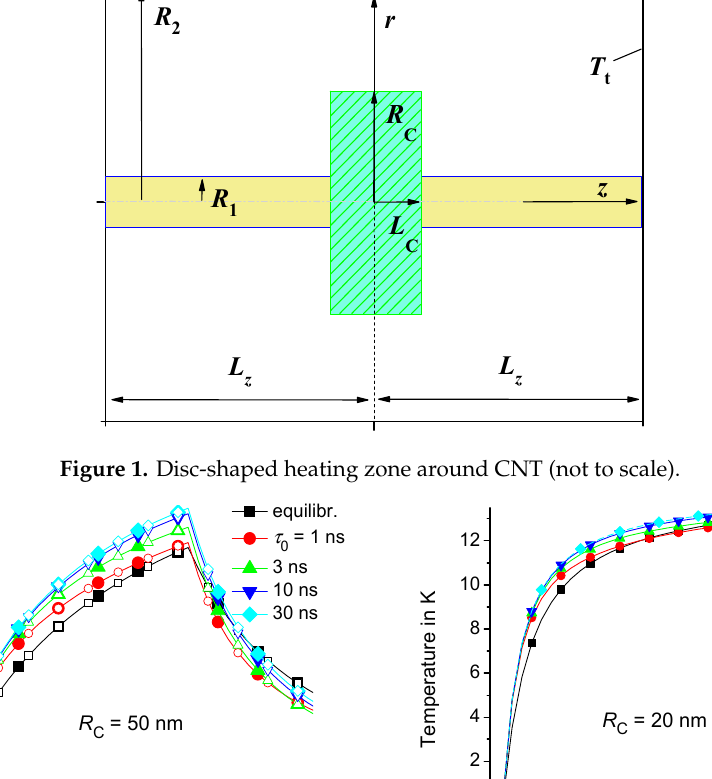
squares and those at nonequilibrium T ( t , R C /2,0 ) at τ 0 = 1 ns, 3 ns, 10 ns, and 30 ns are respectively Figure 2. Time dependence of equilibrium solution 𝑇(cid:3560)(𝑡, 𝑅 (cid:3004) /2,0) is represented by the lines marked